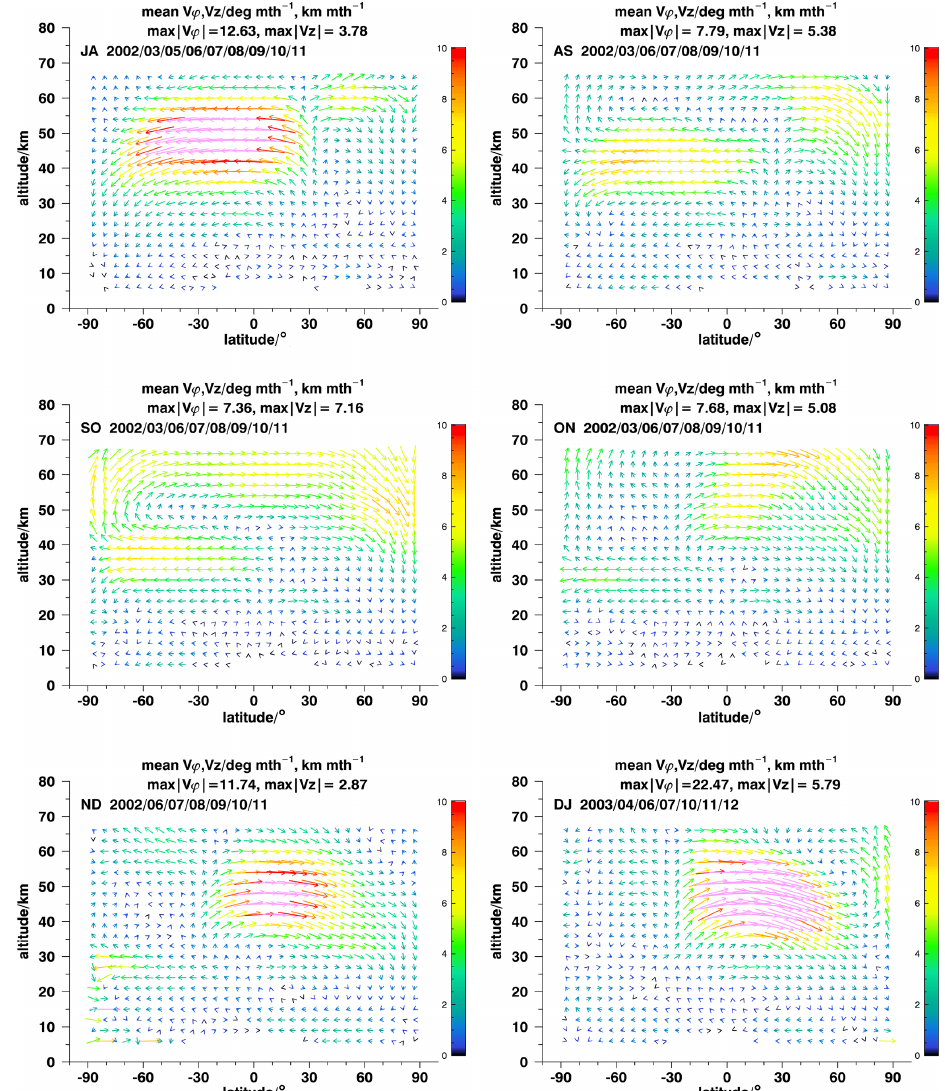
Figure 2. Mean monthly circulation patterns from July–August (top left, JA) to December–January (bottom right, DJ). For details, see Fig.